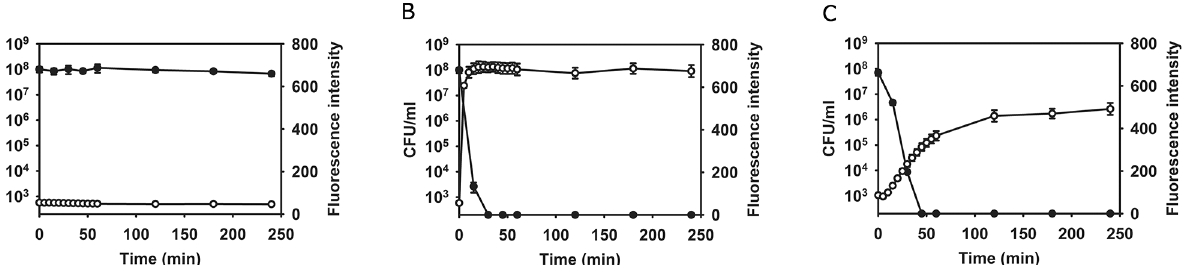
Fig 2. Lysostaphin and nisin kill MRSA persisters by inducing membrane permeabilization. MRSA persisters were treated with 0.1% DMSO (A), 10X MIC lysostaphin (B), or 10X MIC nisin (C). Membrane permeabilization (open circles) was measured spectrophotometrically by monitoring the uptake of SYTOX Green (excitation wavelength of 485 nm and an emission wavelength of 525 nm). Colony forming unit counts of persisters (solid circles) were measured by serial dilution and plating on TSA plates. The data points on the x-axis are below the level of detection (2x10 2 CFU/mL). Results are shown as means ± s.d.; n =